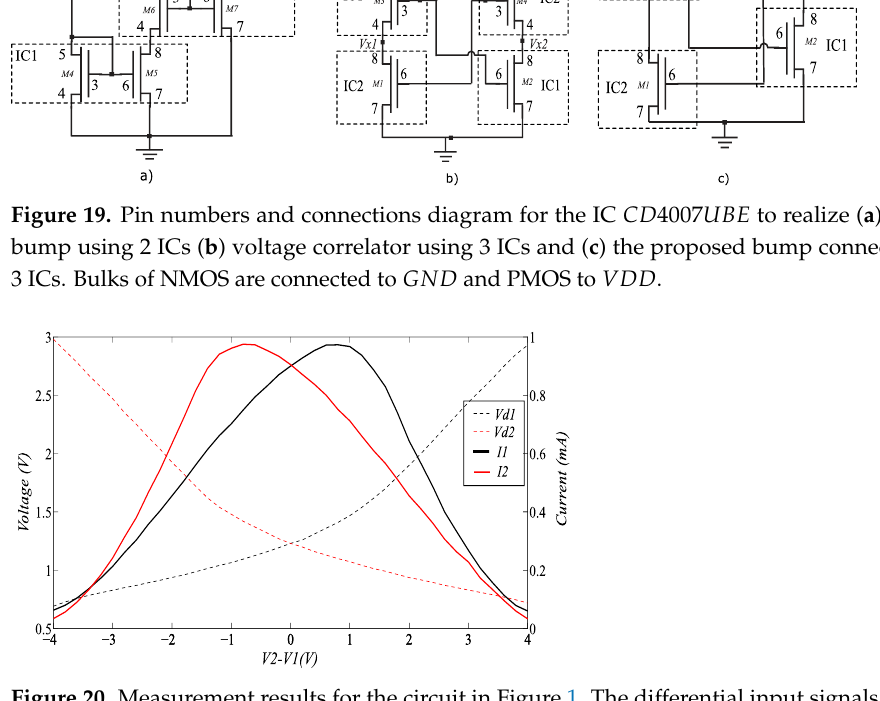
Figure 20. Measurement results for the circuit in Figure 1. The differential input signals V 1 and V 2 are varied in a range [2 V–6 V] with a step of |0.1 V| and characterized by an input common-mode of 4